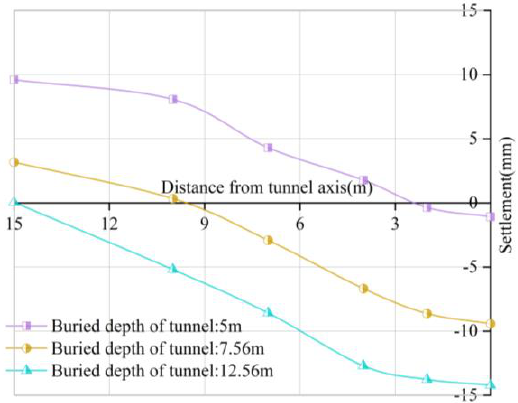
Figure 12. Influence of buried depth of tunnel on the lateral deformation of the ground surface.